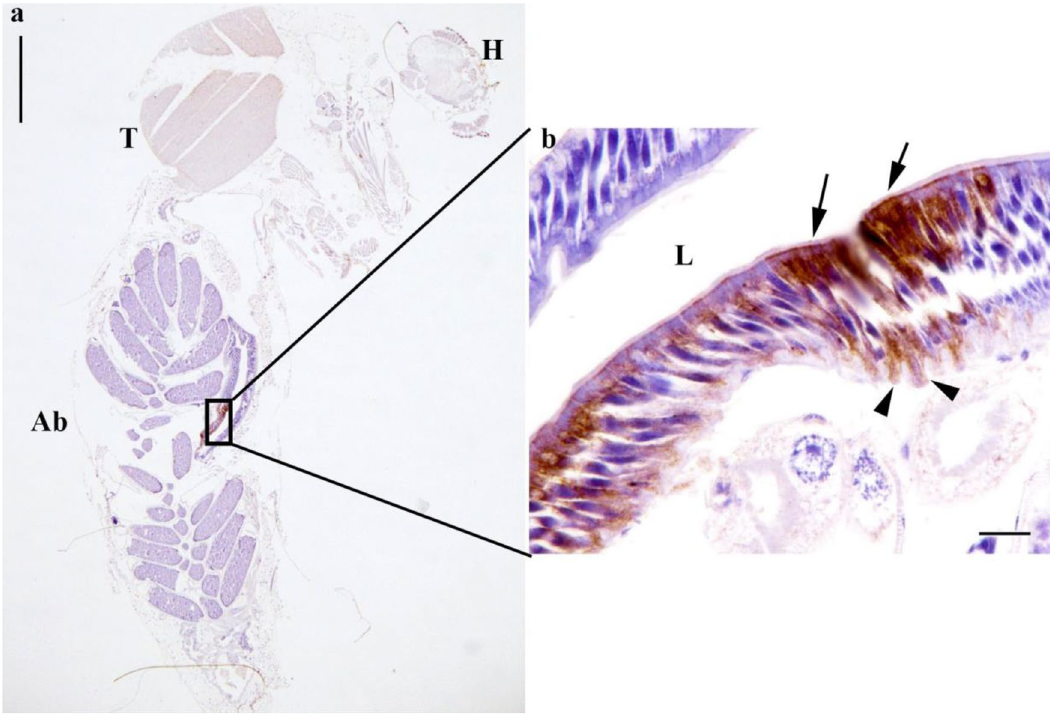
Figure 3. JEV infection of posterior midgut epithelial cells in the C. pipiens . Microscopic features of a blood- fed female mosquitoes. Head (H), thorax (T), abdomen (Ab). Region of interest outlined (rectangle). Scale